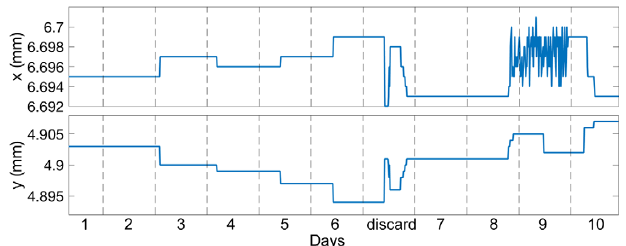
FIG. 10. Steering mirror movement across the days of data acquisition. The data between day 6 and 7 are discarded due to operational interruptions. Top panel: horizontal movement. Bot- tom panel: vertical movement. The positive sign in horizontal direction means the laser moves right, in vertical